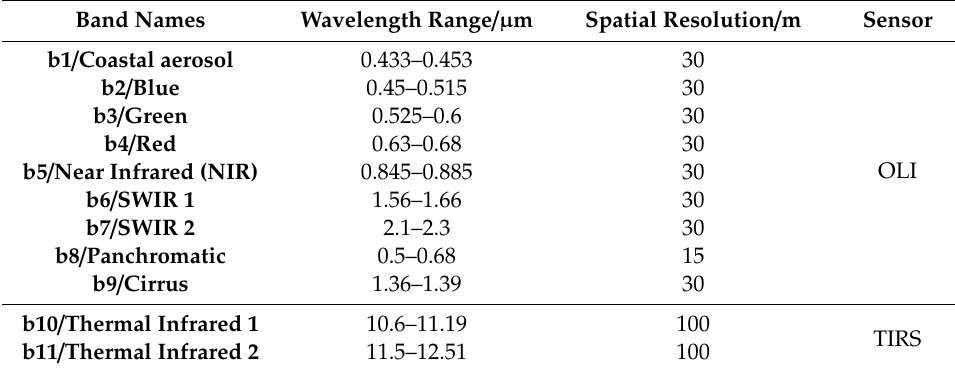
Table 1. Spectral characteristics of Landsat 8.